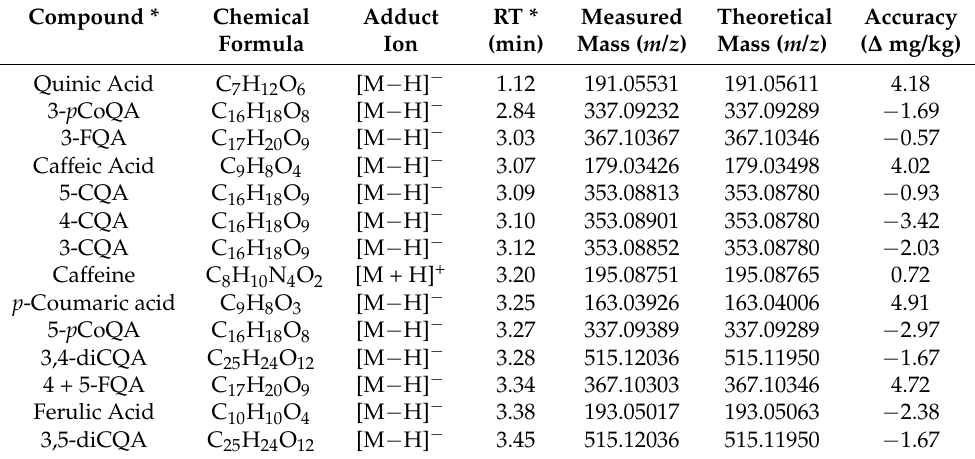
Table 1. UHPLC-MS parameters of the assayed analytes ( n =